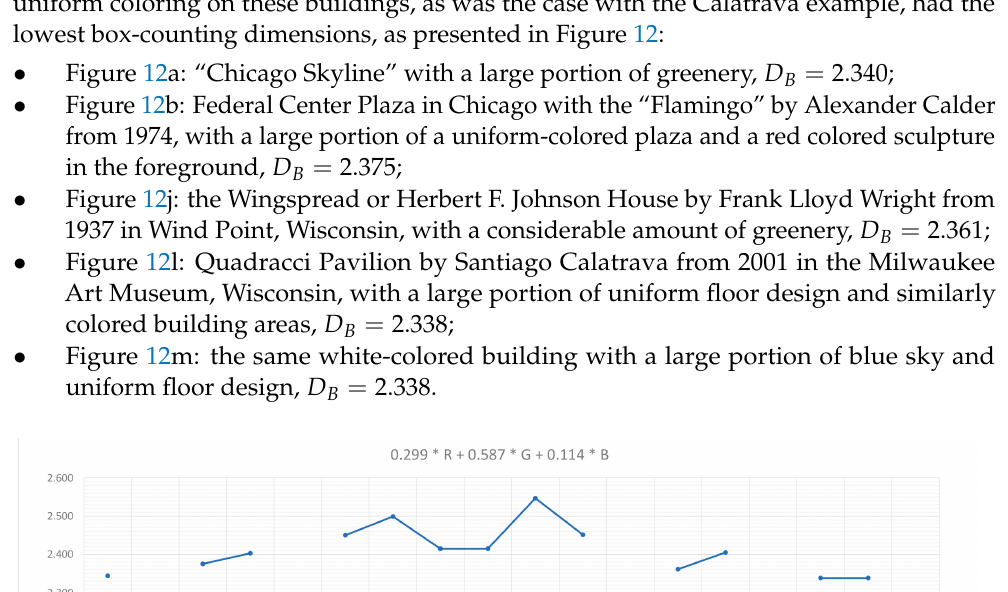
Figure 12a: “Chicago Skyline” with a large portion of greenery, 𝐷 (cid:3003) = 2.340 ; • Figure 12b: Federal Center Plaza in Chicago with the “Flamingo” by Alexander Cal-